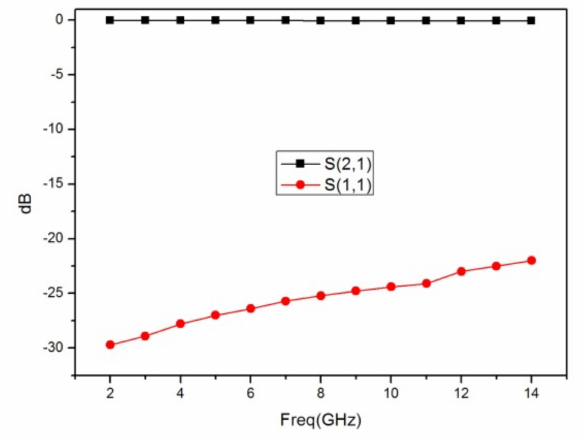
Figure 12. Model simulation results.